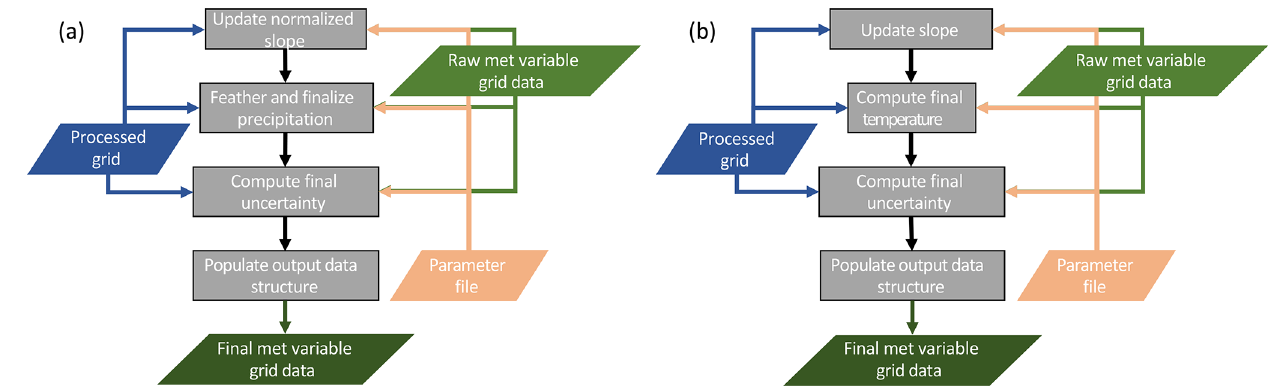
Figure 5. Flowcharts describing the (a) precipitation post-processing and (b) temperature post-processing. Color shading is the same as that in Fig. 1.